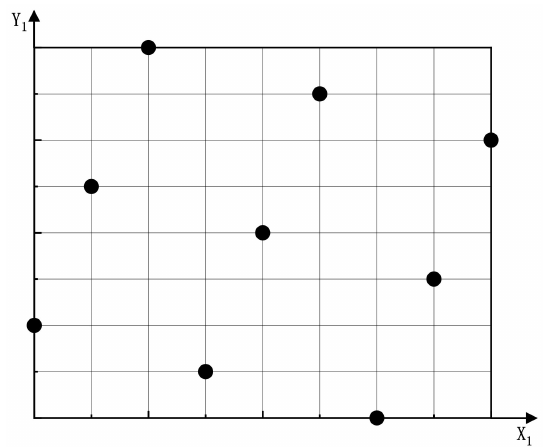
Figure 8. Distribution of optimal Latin hypercube sample points.